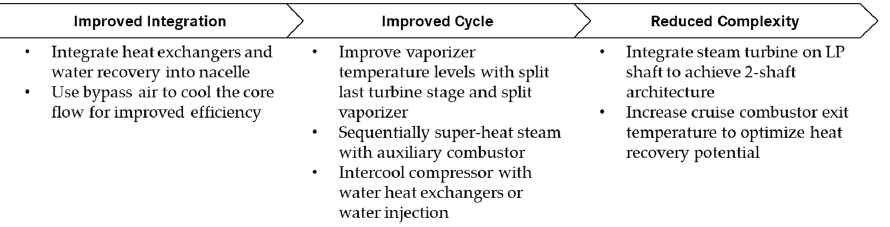
Figure 2. Investigated measures to improve WET concept from an aircraft-mounted water condensation and recovery, published in [9], to a fully nacelle-integrated, simplified concept. In a second stage, measures for cycle improvement were investigated. The focus was placed on optimizing the usage of water and steam within the cycle and maximizing the heat recovery. Splitting the last turbine stage to increase the vaporizer temperature level